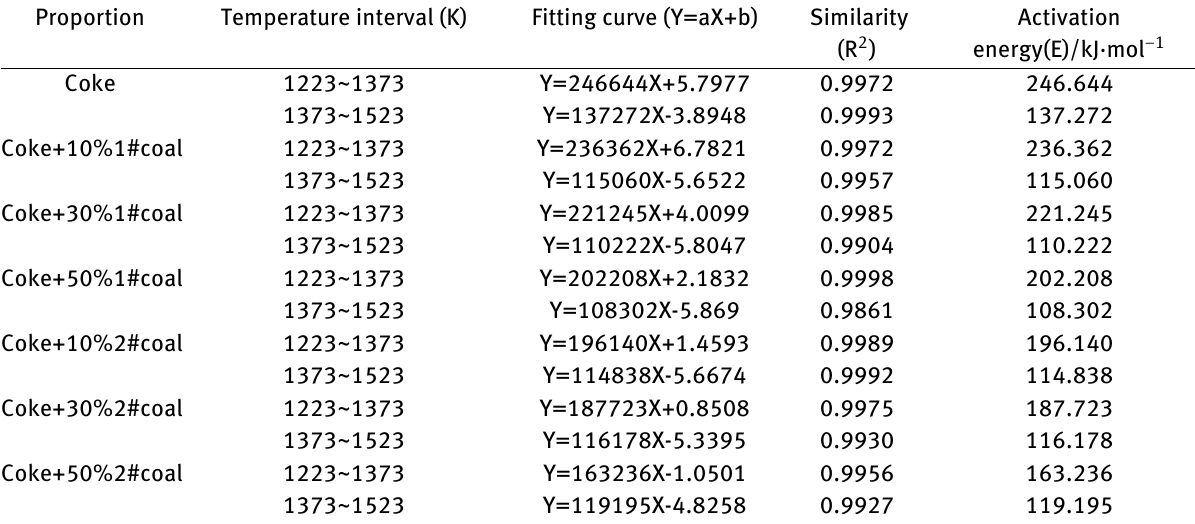
Table 4: Kinetics calculation of carbon dissolving reaction Proportion Temperature interval